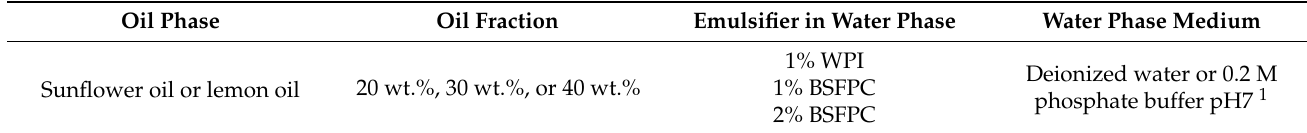
Table 1. Composition of O/W